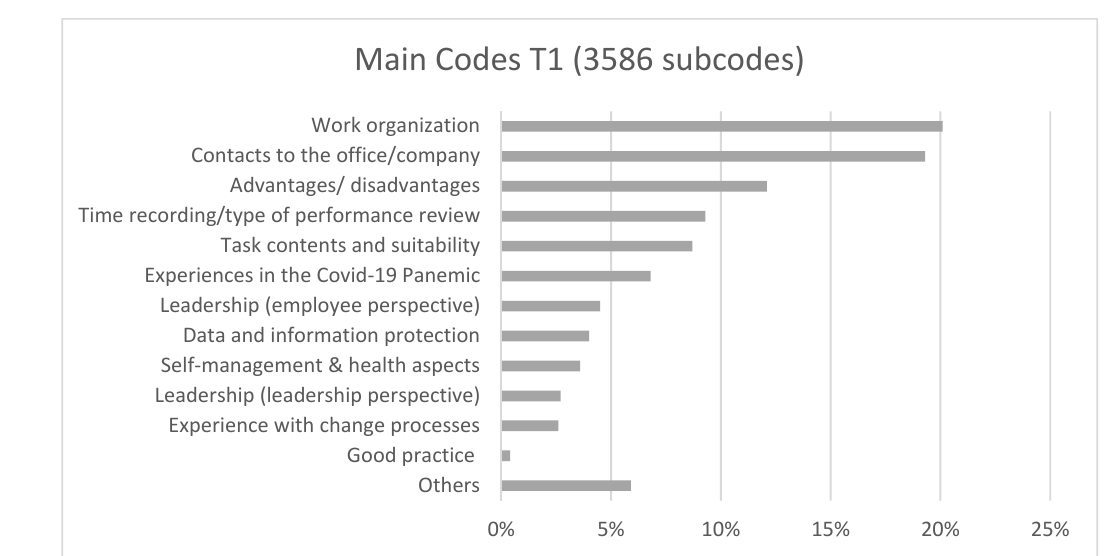
Figure 2. Categorical frequencies of T0.